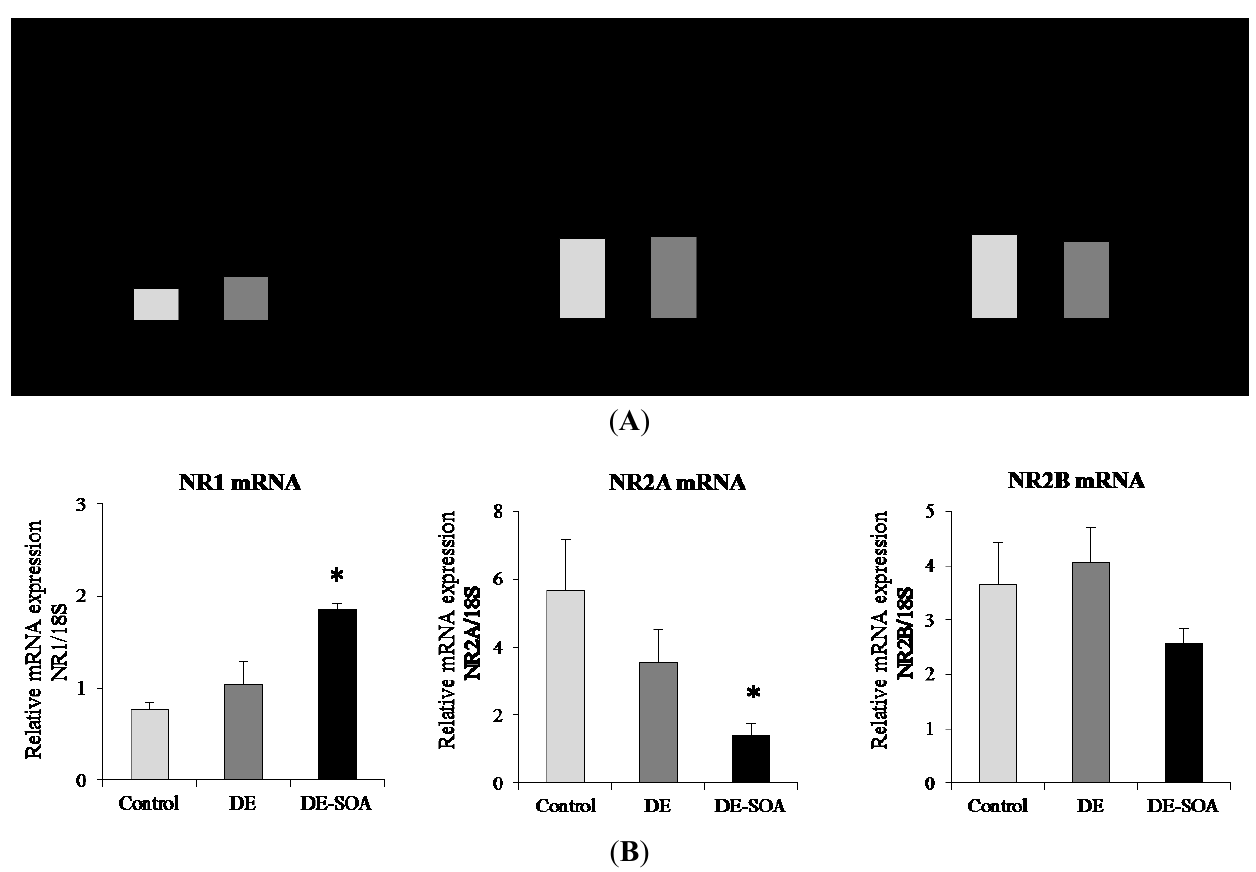
Figure 3. Messenger RNA expression of the NMDA receptor subunits: NR1, NR2A, and NR2B in the hippocampi of mice exposed to clean air, DE, or DE-SOA for ( A ) one month and ( B ) three months. Each bar represents the mean ±